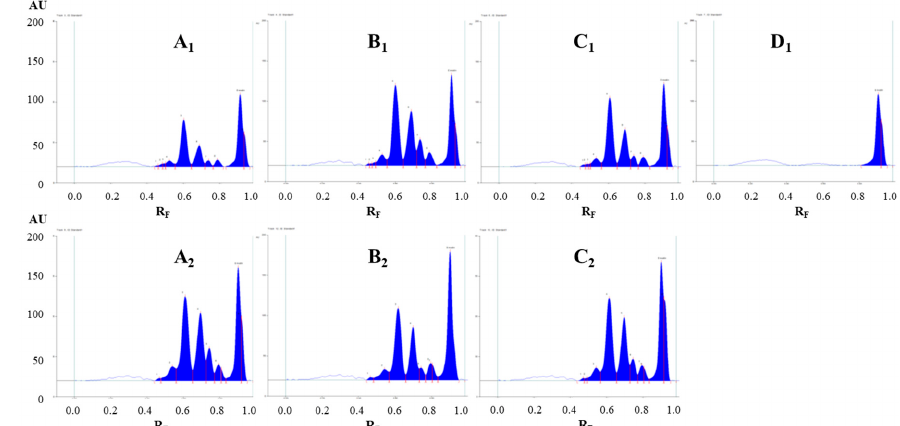
Figure 3. Densitograms of Japanese knotweed rhizomes STSs (2 µ L, 50 mg / mL) scanned at 442 nm in